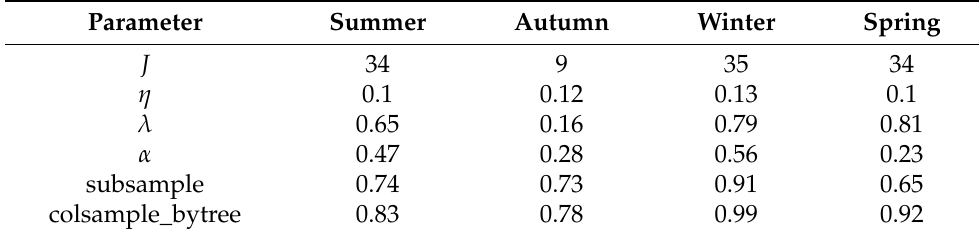
Table 4. Best parameters for each